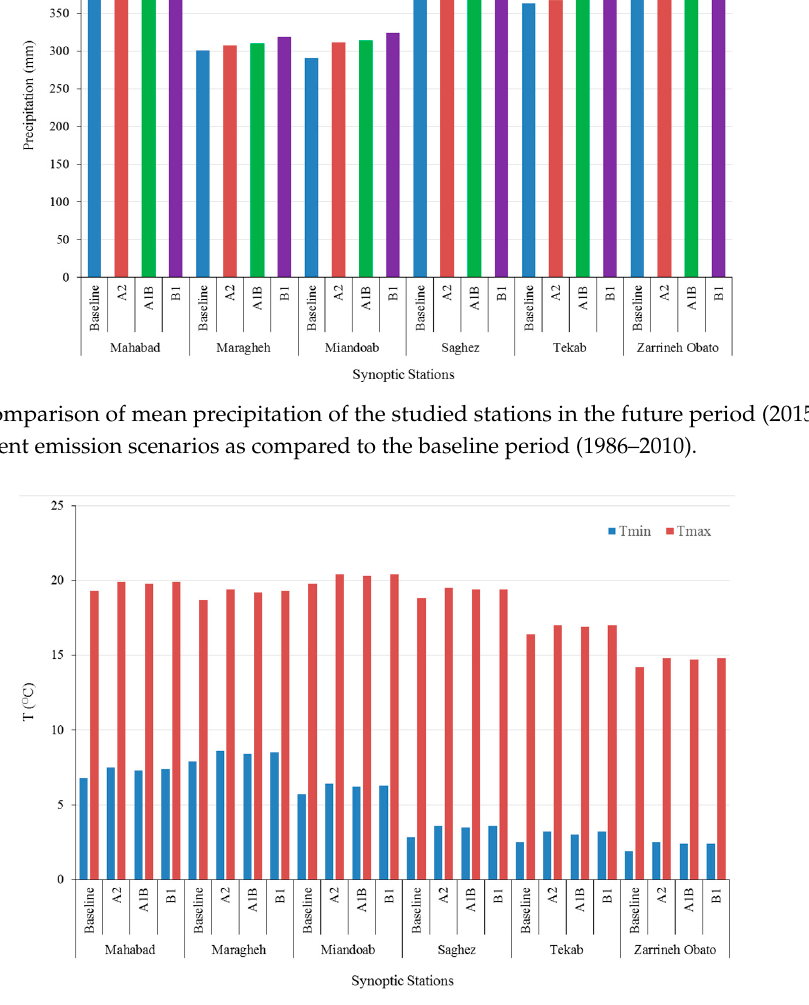
Figure 6. Comparison of mean minimum and maximum temperature of the studied stations in the future period (2015–2040) under different emission scenarios as compared to the baseline period (1986–2010).